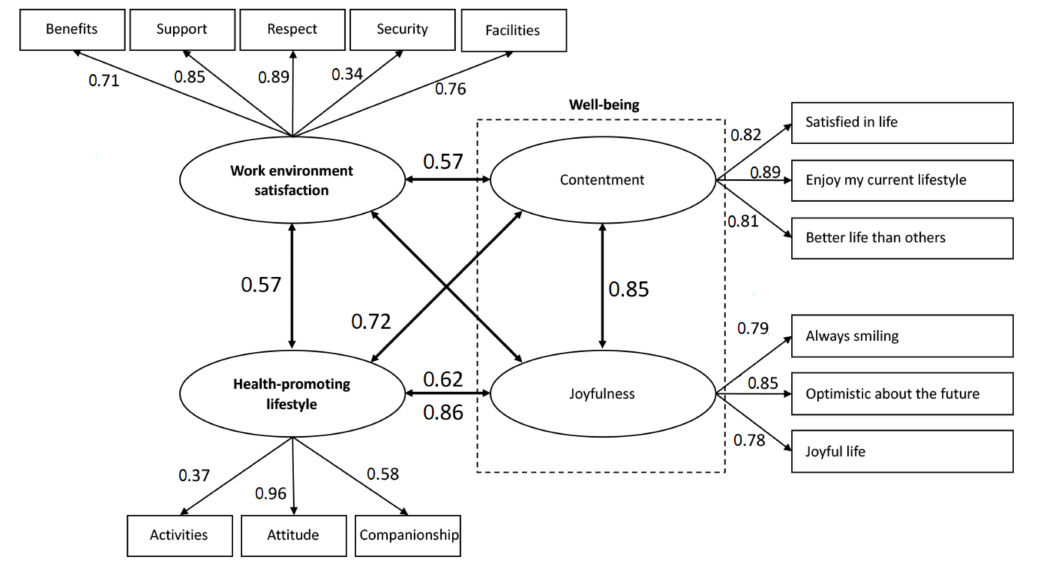
Figure 2. Hypothesized structural model with the obtained path analysis